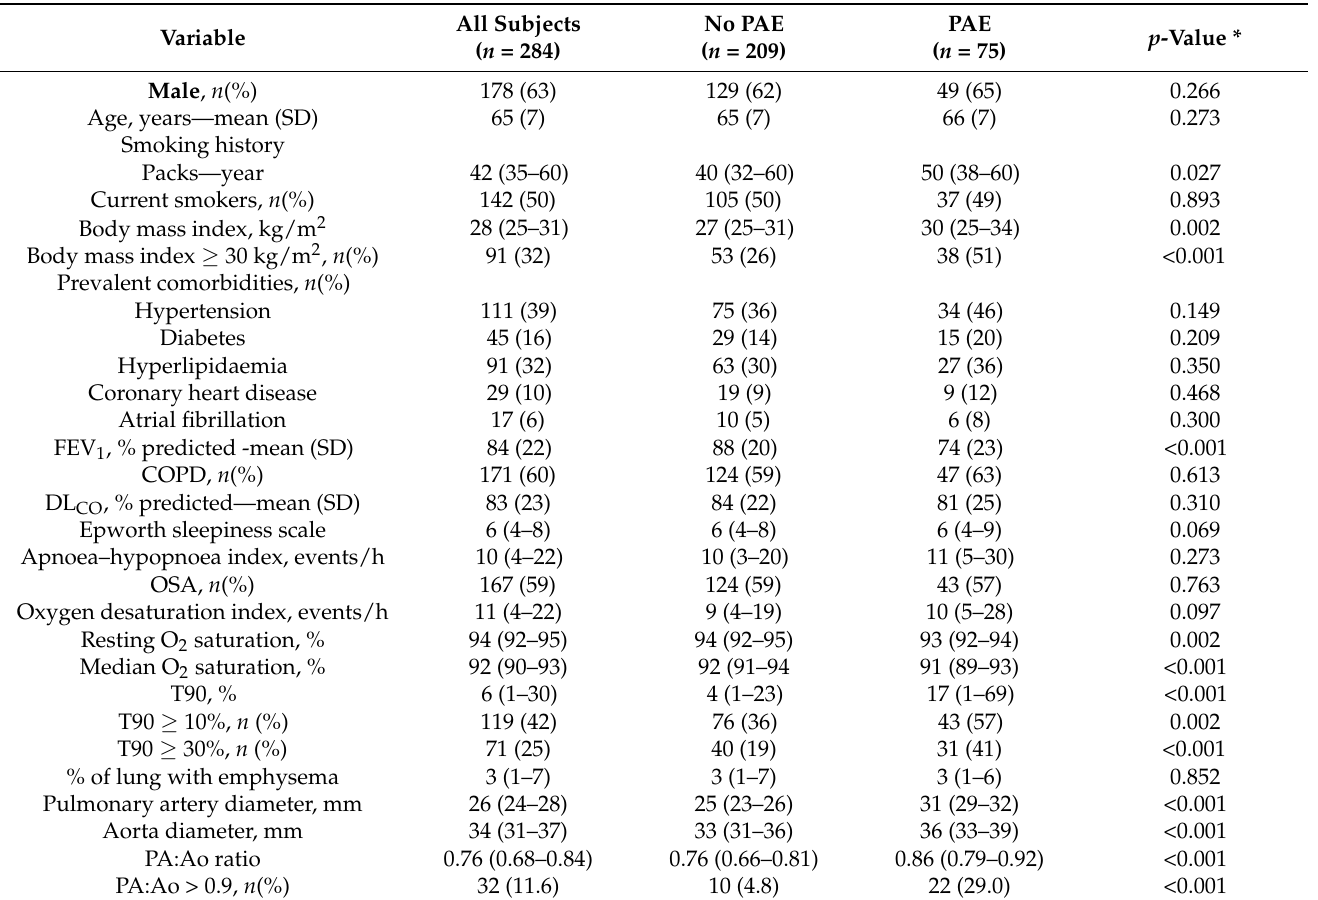
Figure 1. Flowchart of the study. SAILS = Sleep Apnoea in Lung Cancer Screening Study; CHAIN = Chronic Obstructive Pulmonary Disease (COPD) History Assessment in Spain study; CT = chest computed tomography; HSS = home sleep study. Table 1. Baseline characteristics *